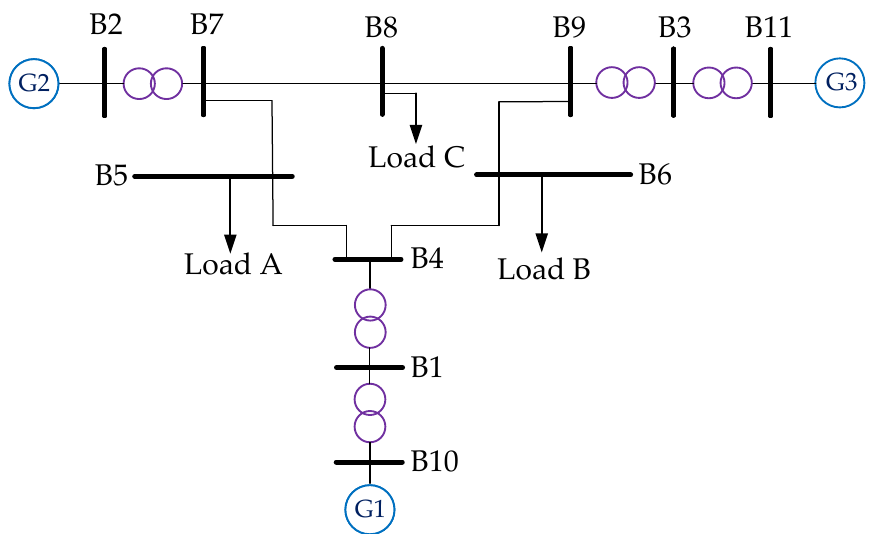
Figure 2. Single-line diagram of the examined